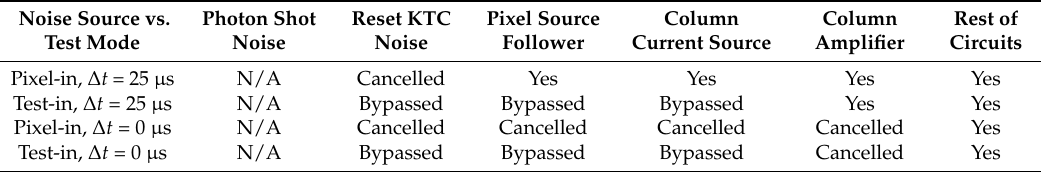
Table 2. The four operation modes and the corresponding temporal noise